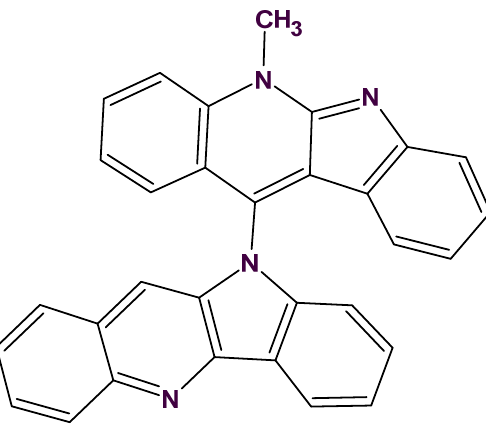
Figure 11. Structure of quindolinocryptotackieine 7.